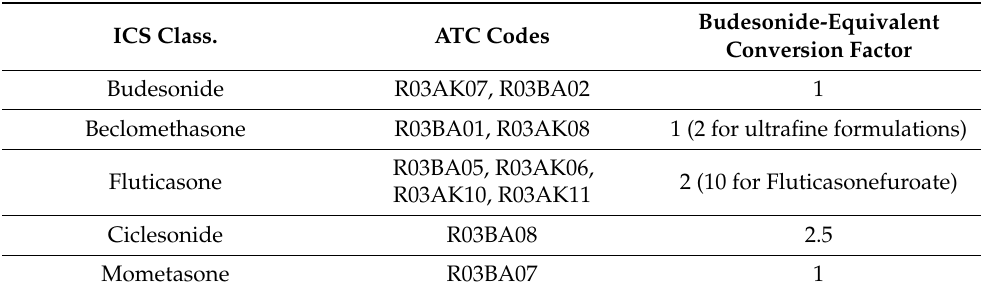
Table A1. ATC codes used to define ICS as well as their budesonide-equivalent conversion factor. ICS Class.